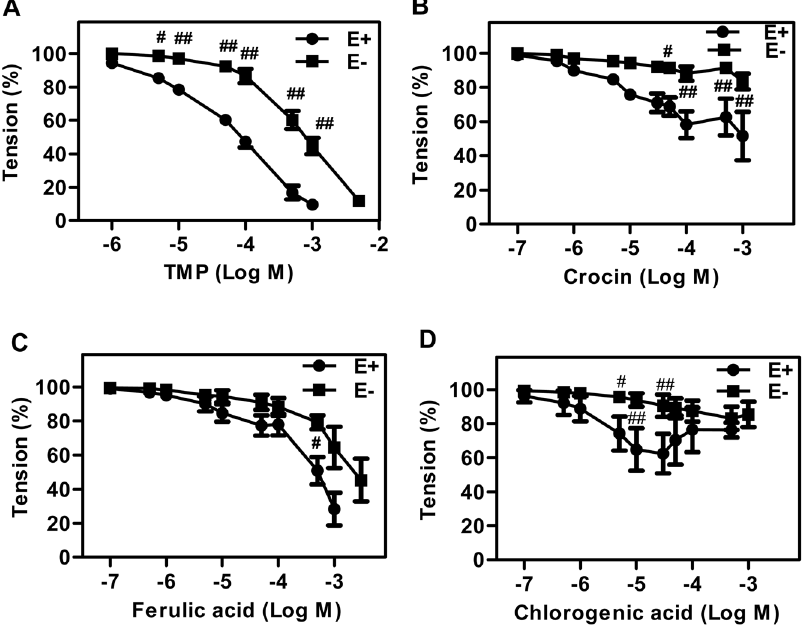
Figure 1. Vasorelaxant effects of TMP on rat aortic rings. The freshly isolated rat aortic rings were treated with ( A ) TMP, ( B ) crocin, ( C ) ferulic acid and ( D ) chlorogenic acid at increasing concentrations. After the treatments, both endothelium-intact (E + ) and endothelium-denuded (E 2 ) ring relaxation were measured as described in the Methods. Data are mean 6 SEM (n=4–7). ## P , 0.01 vs. E + ; # P , 0.05 vs. E + .